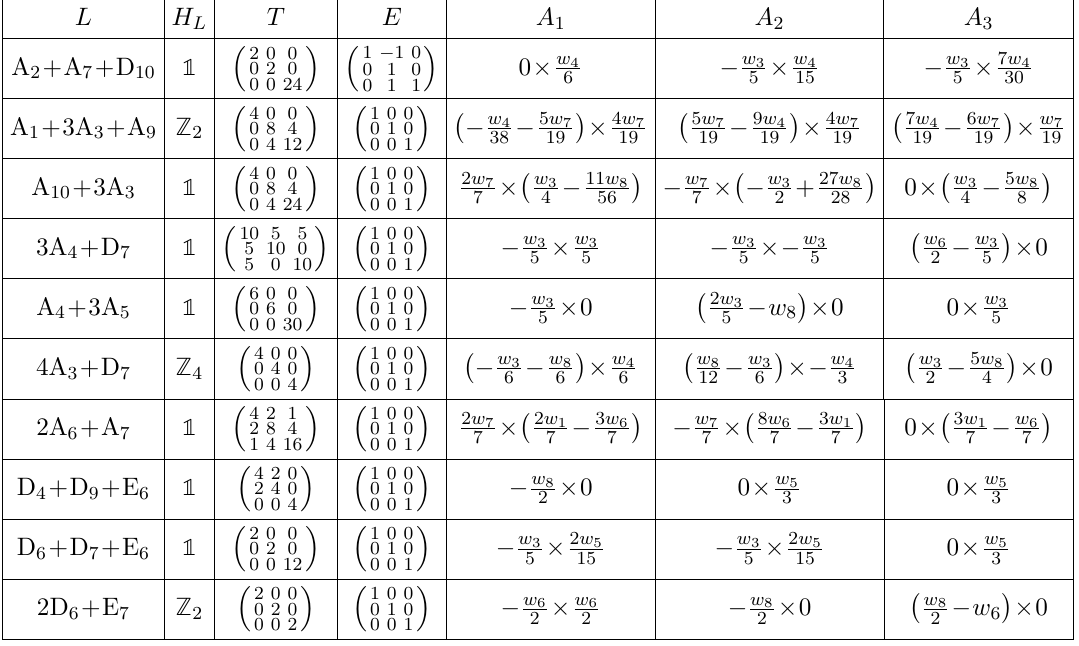
Table 10. Data for some groups of maximal rank, for the E 8 (cid:2) E 0